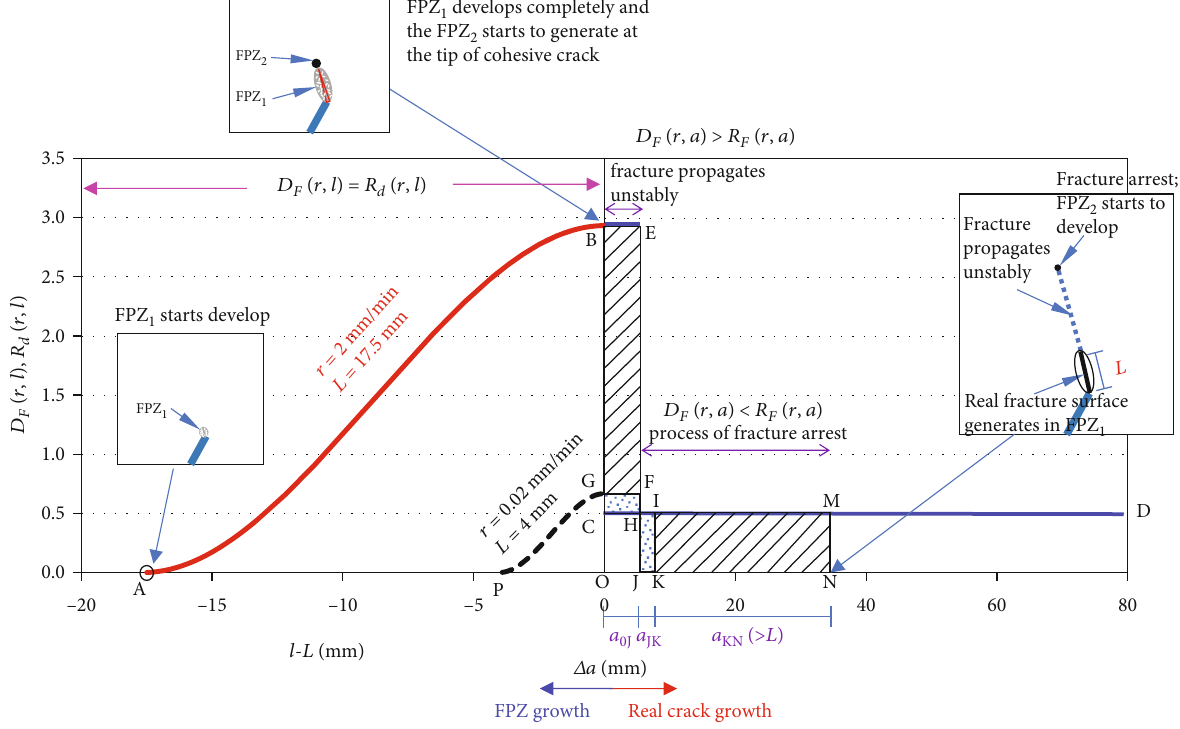
Figure 6: Schematic diagram of fracture resistance and driving force curves corresponding to the unstable propagation of mixed-mode cracks at di ff erent loading